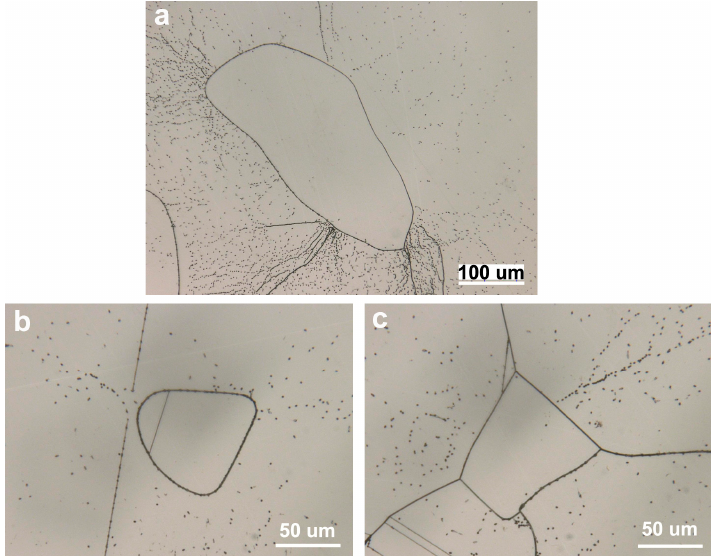
Figure 5. Image of grains containing few dislocations or free of dislocations: ( a ) and ( b ) embedded within a larger grain, and ( c ) located at the junction of four larger grains.